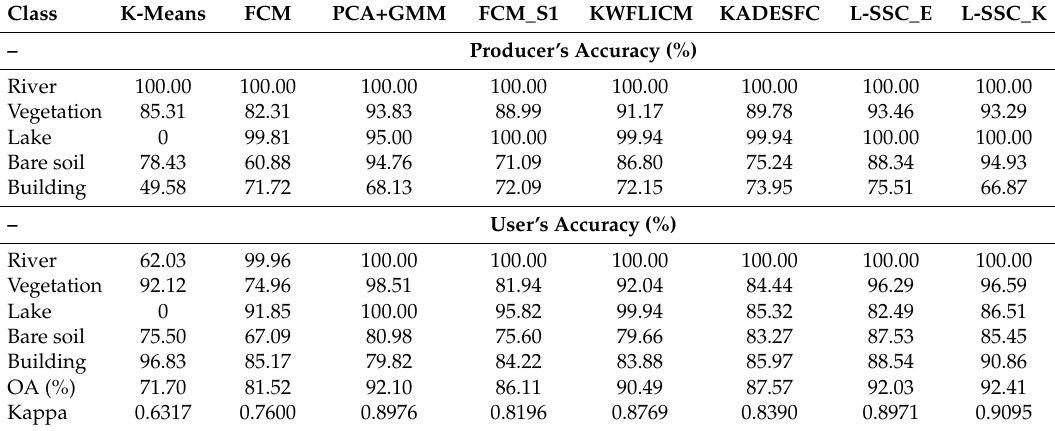
Table 2. Comparison of clustering accuracy for Wuhan TM